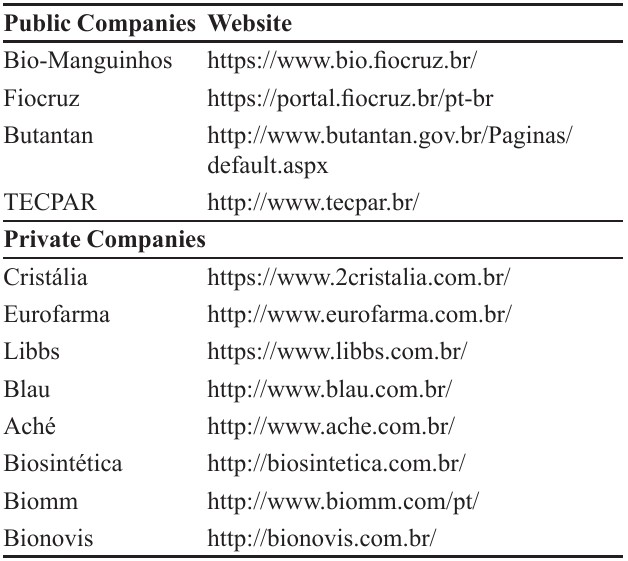
TABLE II - Visited websites during the period of December